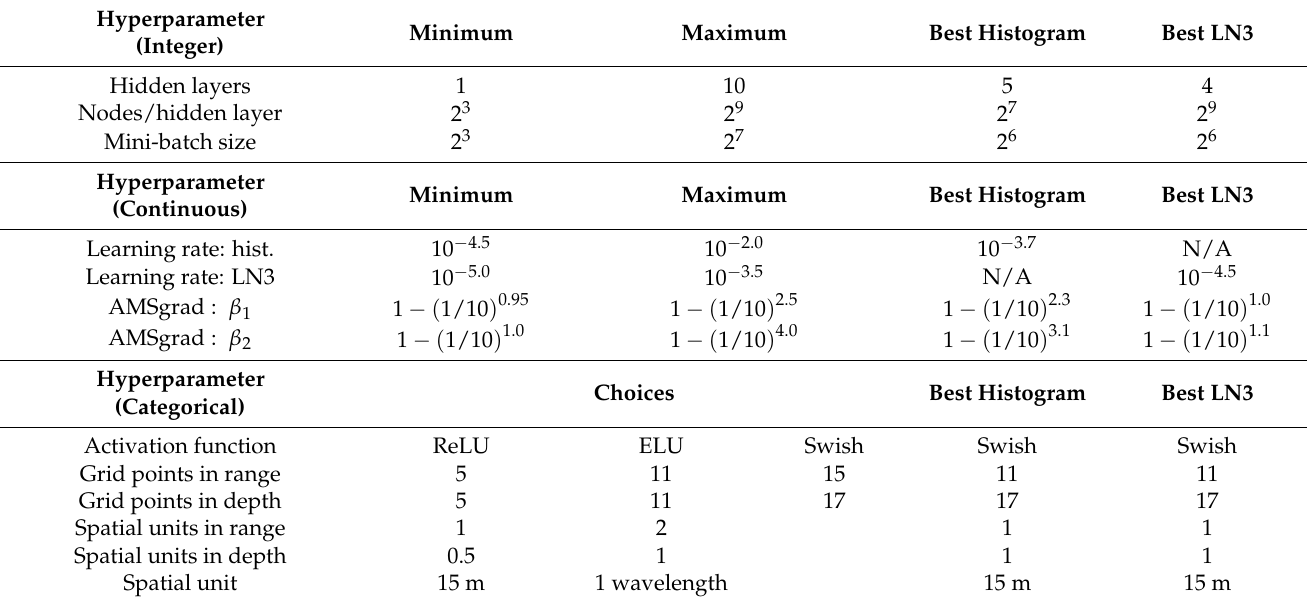
Table A1. List of investigated hyperparameters, the ranges of values explored, and the values corresponding to the best attempted configuration for each output